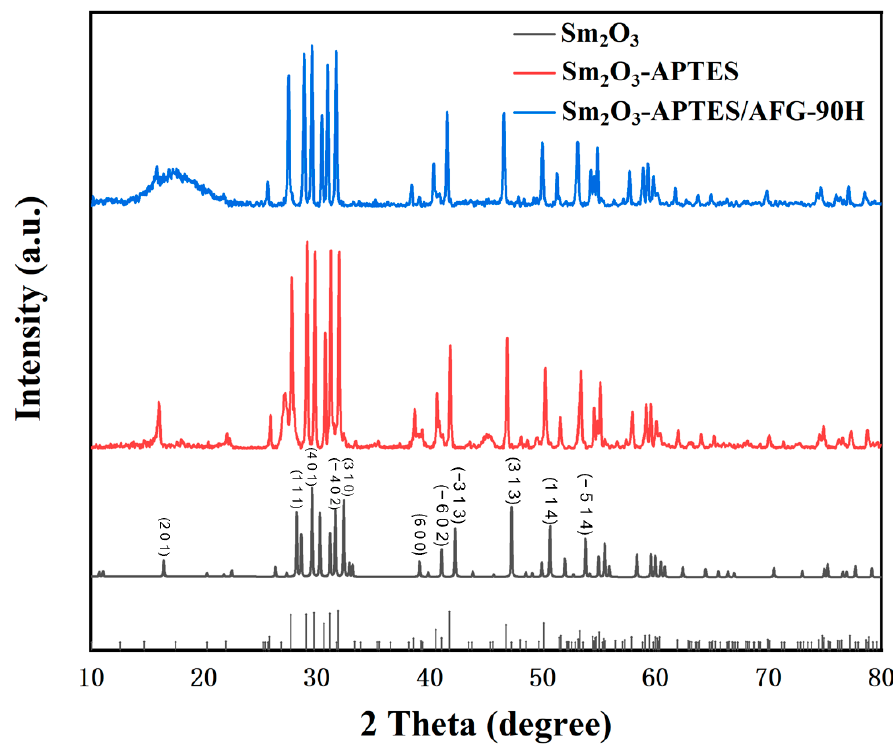
Figure 5. XRD patterns of Sm 2 O 3 , Sm 2 O 3 -APTES and Sm 2 O 3 -APTES/AFG-90H.